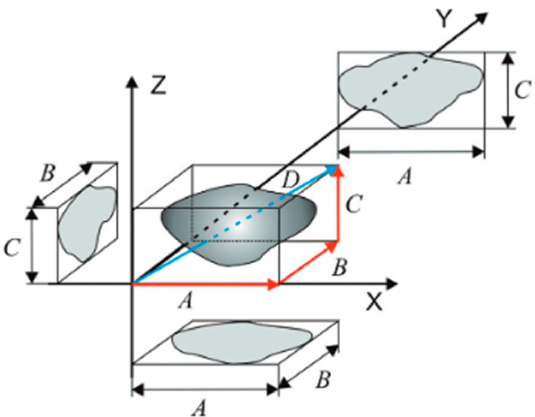
Figure 1. A scheme of determination of basic dimensions of a particle. Red arrows denote projections of main dimensions, blue arrow—maximum diagonal of particle [29].